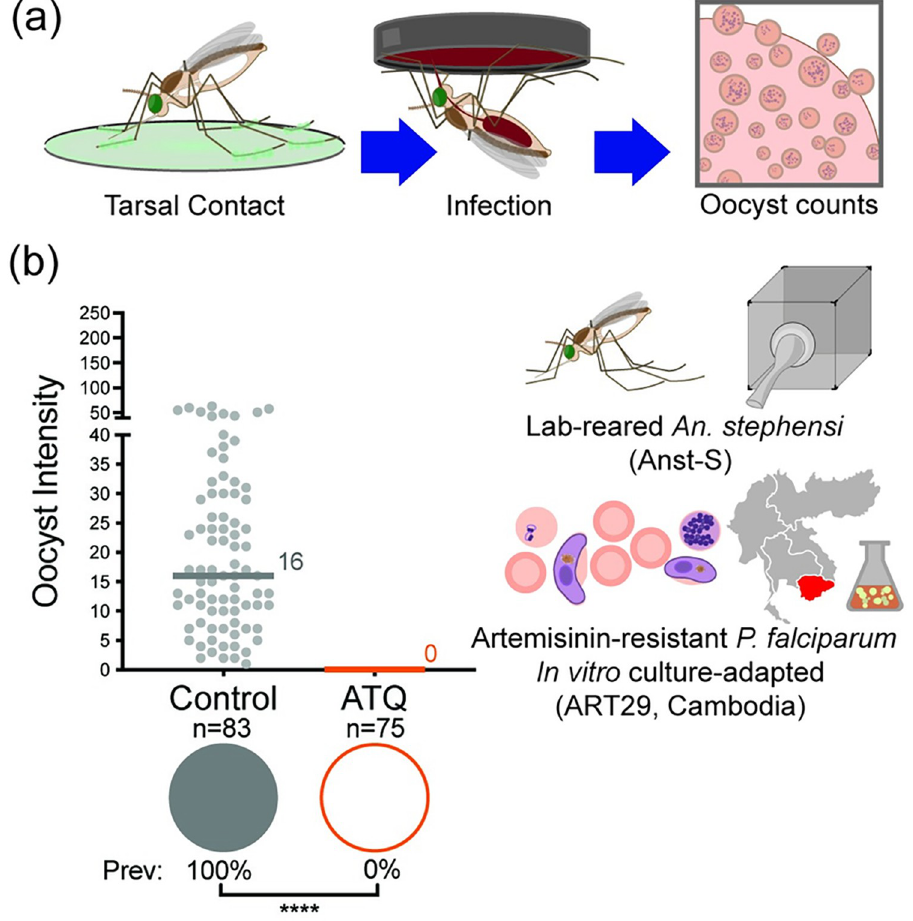
Fig 2. Exposing An . stephensi to ATQ blocks an artemisinin-resistant P . falciparum patient isolate from Cambodia. (a) Experimental scheme. (b) Transmission of artemisinin resistant P . falciparum (ART29) is completely blocked when An . stephensi females (Anst-S) are exposed to ATQ for 6 min to the maximal effective concentration (EC 99 ) for insecticide-susceptible mosquitoes. In ATQ exposed mosquitoes, prevalence (indicated by pie charts) was zero despite robust infection in mock-exposed controls (Chi 2 , n = 158, df = 1, Χ 2 = 156, p < 0.0001). Median lines and values are indicated, “n” indicates the number of independent samples. To isolate Oocyst Prevalence and Oocyst Intensity, midgut samples with zero oocysts have been excluded from intensity analysis. Statistical significance is indicated where relevant as follows: ns = not significant, � = p < 0.05, �� = p < 0.01, ��� = p < 0.001, ���� = p < 0.0001.